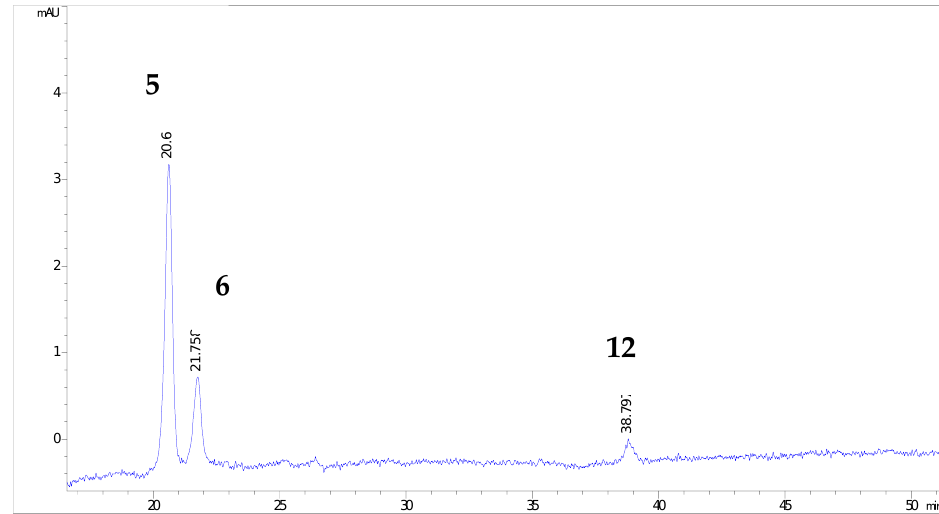
Figure 3. HPLC chromatograms of investigated black mulberry juice and anthocyanin compounds identified at 520 nm ( A ) before hydrolysis (the numbers refer to corresponding peaks, presented in Table 1): cyanidin-3-O-glucoside (16), cyanidin-3-O-rutinoside (17); ( B ) after hydrolysis: cyanidin chloride (18).